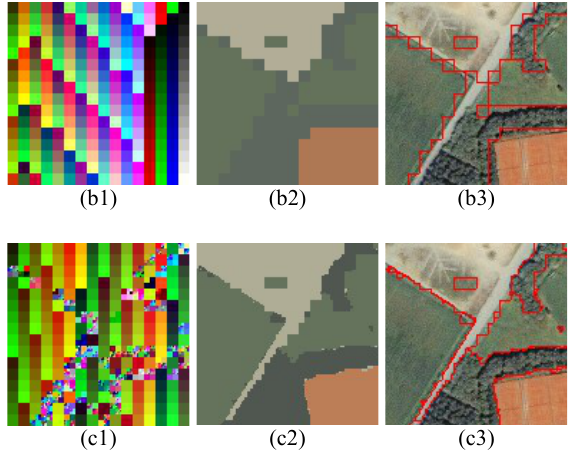
Figure 5. IKONOS image and its segmentation results. (a1) IKONOS image, (a2)-(a3) HMRF-FCM, (b1)-(b3) RT- HMRF-FCM, (c1)-(c3) The proposed algorithm Figure 6 is buffer area analysis by constructing buffer for segmentation boundary and truth boundary, where columns 1-3 represent HMRF-FCM, RT-HMRF-FCM and the proposed algorithm, rows 1, 3, and 5 are the comparison of segmentation boundary and the buffer area of truth boundary, rows 2, 4, and 6 are the comparison of truth boundary and the buffer area of segmentation boundary. The green is right pixels, the red in Figure 6(a1)-(a3), (c1)-(c3) and (e1)-(e3) represents the redundant boundary in segmentation results, the red in Figure 6(b1)-(b3), (d1)-(d3) and (f1)-(f3) represents the deficient boundary in segmentation results. It can be seen that both redundant and deficient boundaries of the proposed algorithm segmentation results are the least compared with